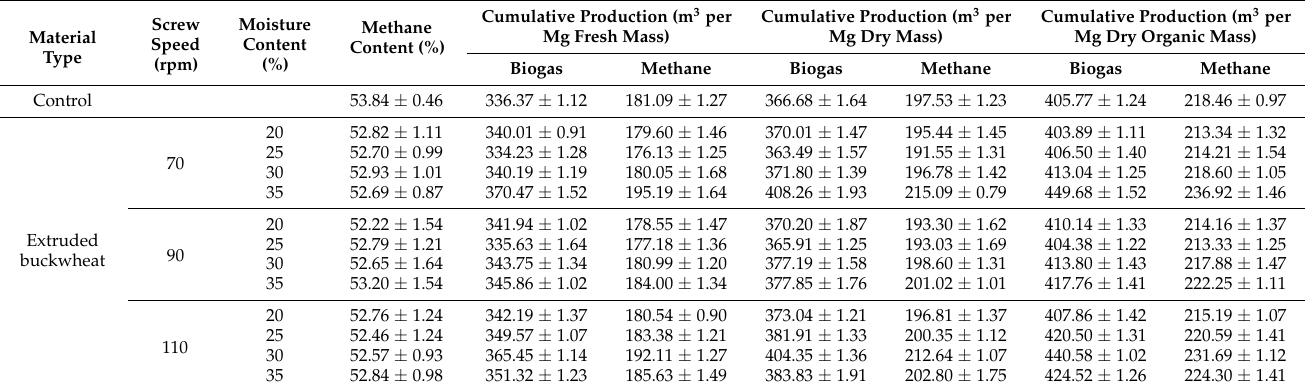
Table 7. Biogas efficiency of extruded buckwheat straw (before modification of the extruder screw; ± SD).